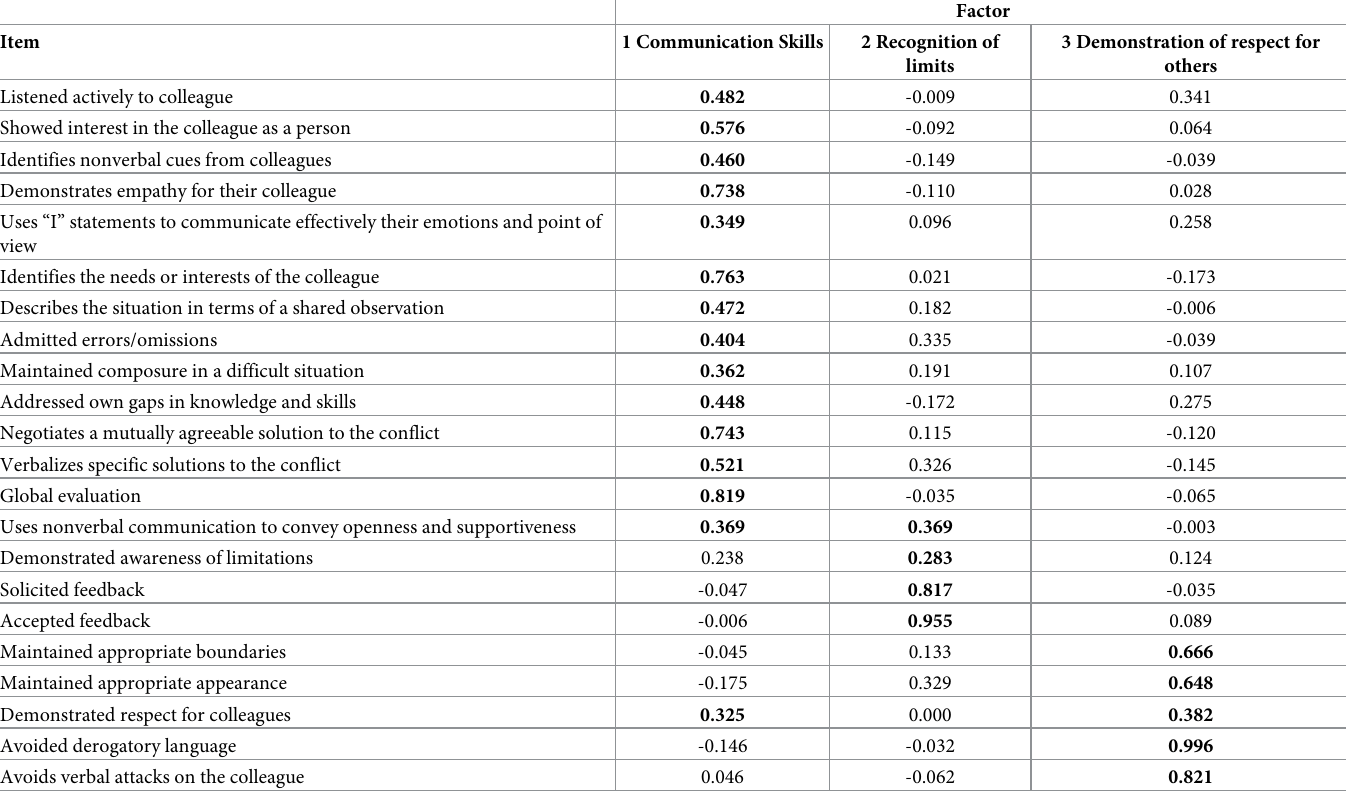
Table 2. Exploratory factor analysis of the ICE: Factor loadings based on rotated factor matrix